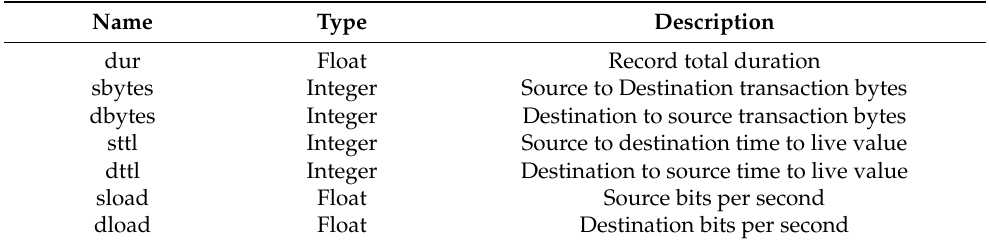
Table 4. Input features for